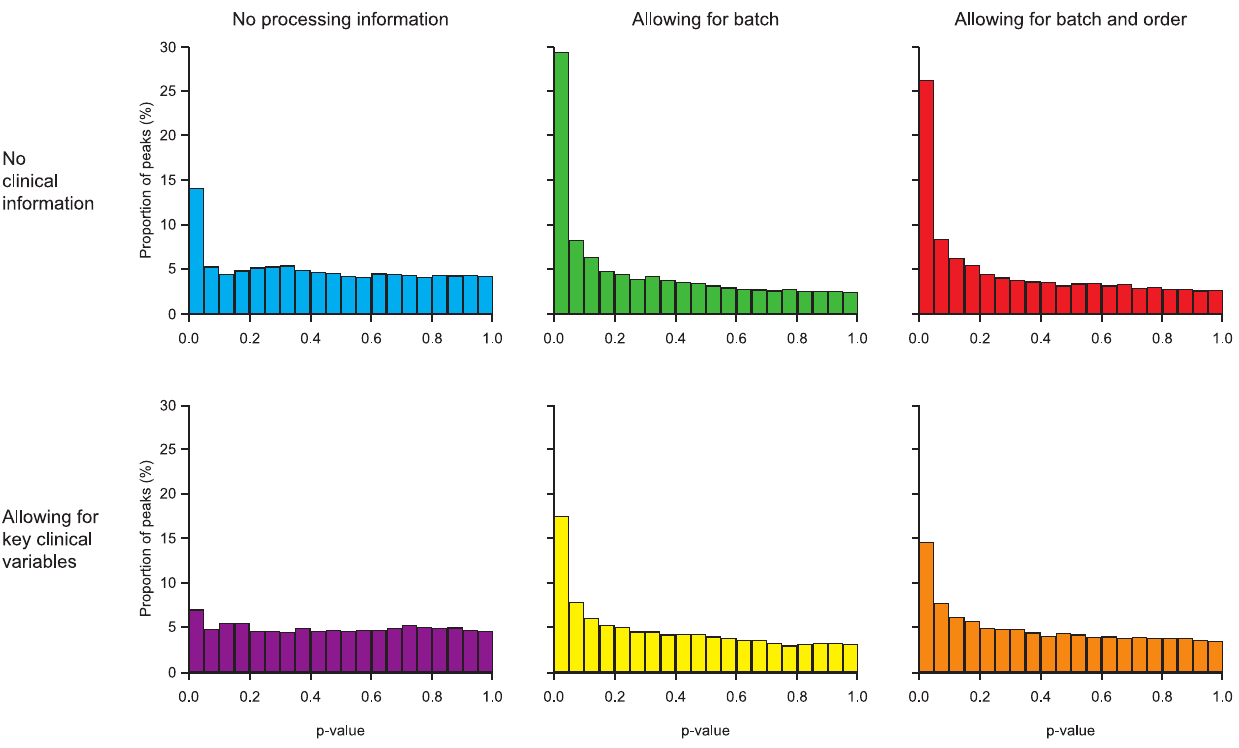
Figure 3. Distribution of significance tests of differential expression between cases and controls for individual peptides. The figure shows the effect on the distribution of p-values for differential expression of including analysis processing information and clinical variables.